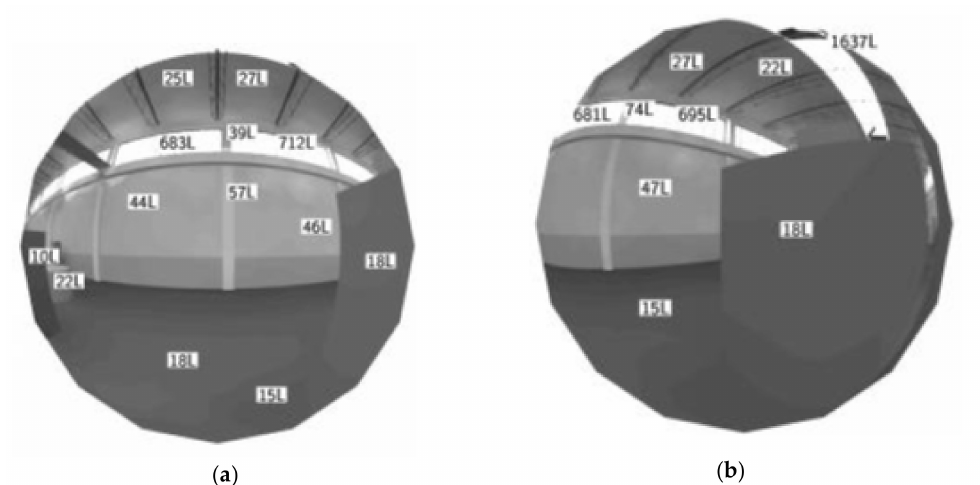
Figure 5. Result of simulated point values of brightness (luminance value cd.m − 2 ) at the workplace using wire skylight glazing: ( a ) overcast sky, north view; ( b ) overcast sky, northeast view.